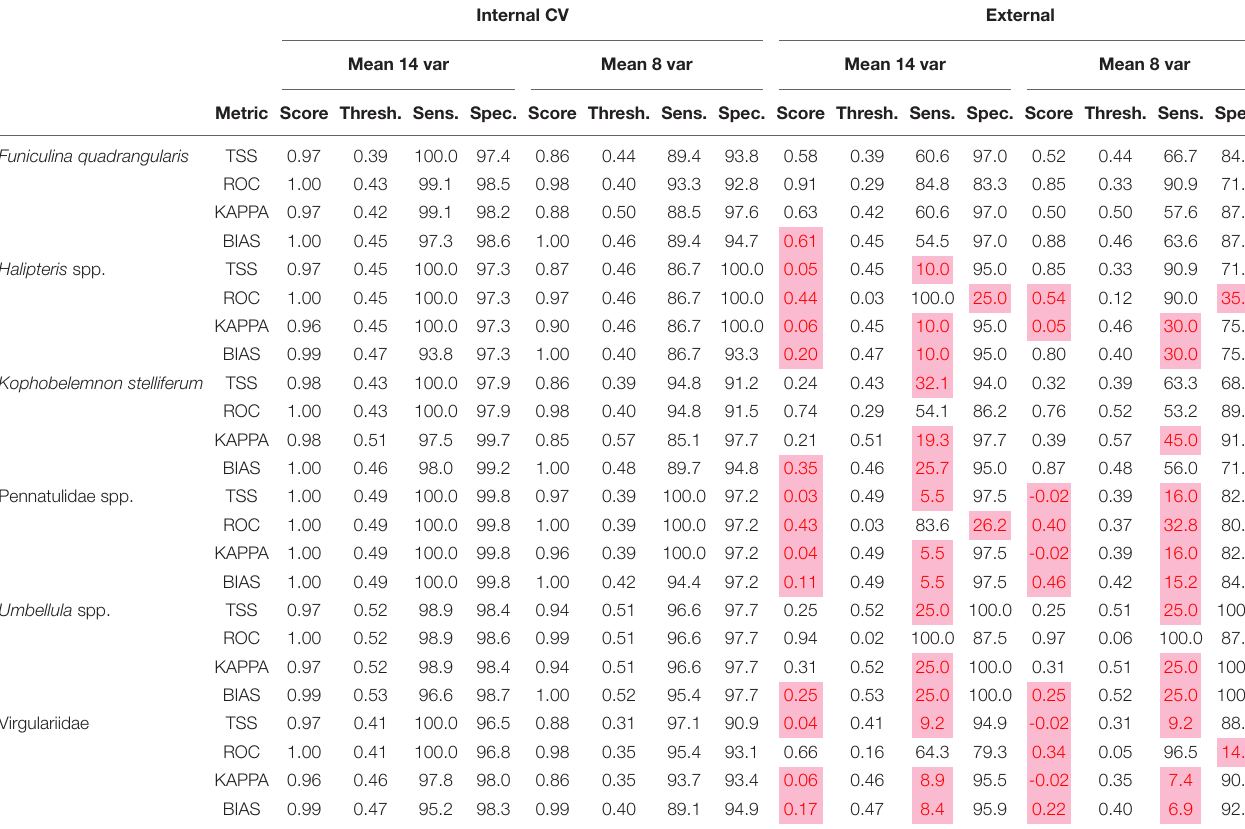
TABLE 3 | Summarised model evaluation scores for the internal and external ensemble model predictions.